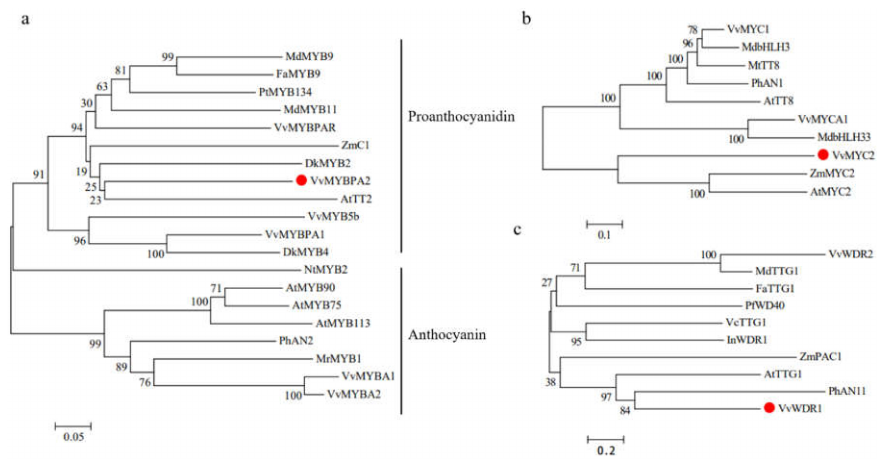
Figure 3. Phylogenetic analysis of transcription factors related to grape proanthocyanidin synthesis. ( a – c ) means the phylogenetic relationships between MYB, bHLH, WD40 transcription factors with their closest homologues,